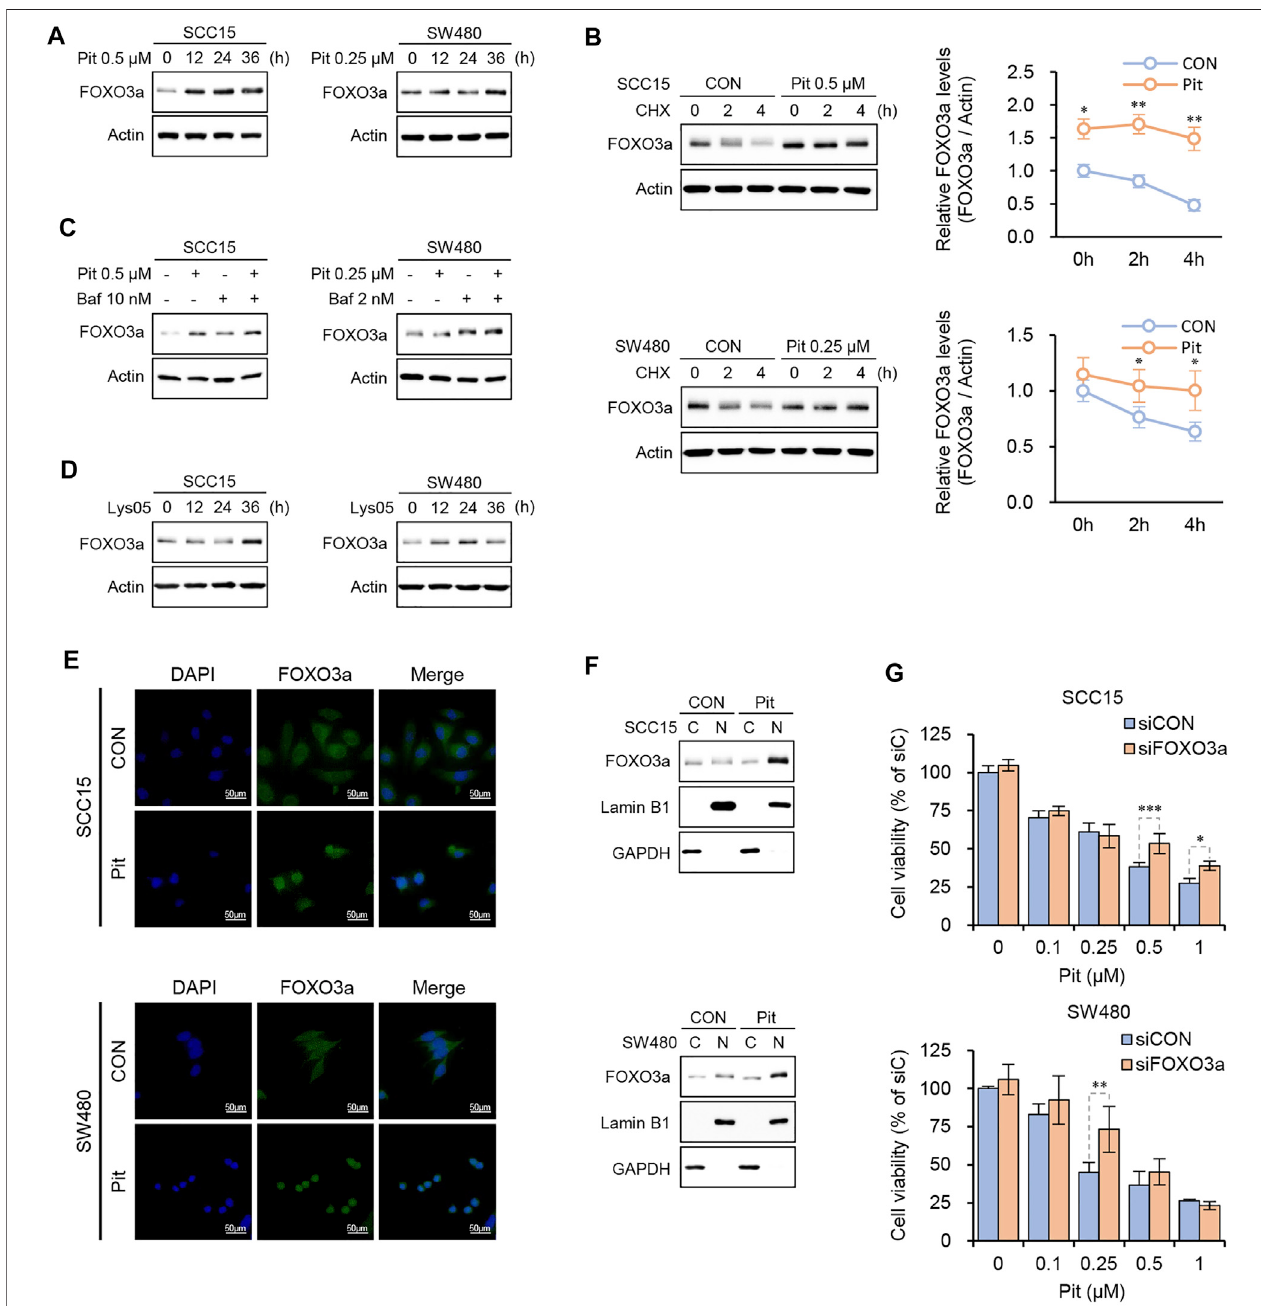
FIGURE 4 | Pitavastatin increased the stability of FOXO3a protein. (A) Cells were treated with pitavastatin for the indicated times and the protein levels of FOXO3a were measured by western blot analyses. (B) Cells were treated with pitavastatin in presence or absence of CHX (10 μ g/ml) to measure the degradation dynamics of FOXO3a by pitavastatin. ImageJ software was used for quantitation of FOXO3a protein levels. Statistical analysis was performed using two-way ANOVA. Error bars representmean±SD( n =3).* p < 0.05;** p < 0.01. (C,D) CellsweretreatedwithpitavastatininthepresenceorabsenceofBa fi lomycinA1 (C) ortreatedwithLys05 (3 µM) (D) for24 h,andtheproteinlevelofFOXO3awasmeasured bywesternblotanalyses. (E) SCC15andSW480cellsseededonsterilecoverslipsweretreatedwith pitavastatin for 24 h. Cells were then fi xed with methanol, followed by incubation with fl uorescently tagged rabbit polyclonal FOXO3a antibody and stained with Alexa Fluor 488 (green)-labelled anti-rabbit antisera and DAPI. FOXO3a signals were then visualized by confocal microscopy. (F) After treatment of SCC15 and SW480 cells with pitavastatin for 24 h, the nuclear translocation of FOXO3a protein was measured by western blot analyses with GAPDH and Lamin B1 as the cytoplasmic and nuclearloadingcontrols,respectively. (G) Cellsplatedon96-wellplatesweretransfectedwithFOXO3asiRNAinthepresenceorabsenceoftheindicatedconcentrations ofpitavastatinandincubatedfor48 h.CellviabilitywasthenmeasuredusingtheCytoTox-Glocytotoxicityassay.Statisticalanalysiswasperformedbytwo-wayANOVA. Error bars represent mean ± SD ( n = 4). * p < 0.05; ** p < 0.01; *** p < 0.001.